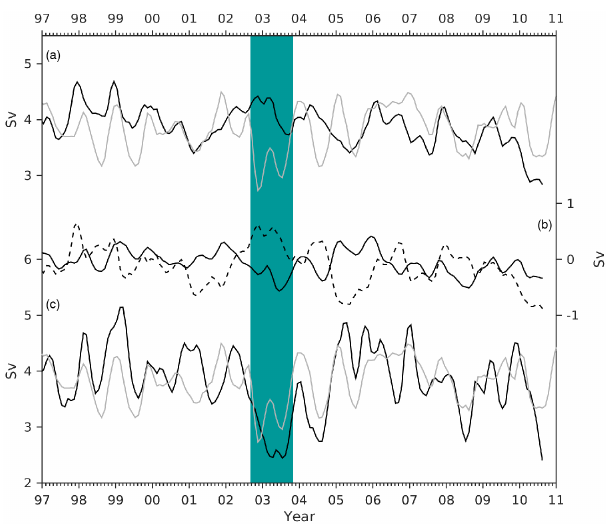
Figure 2. Three-month running mean time series of observed (grey; see Sect. 4.2) and modelled (black) IF-inflow (a) . Anomalies (run- ning mean) in modelled components on the Icelandic side (dashed) and Faroe side (solid) are shown in (b) . Modelled transport of wa- ter denser than 27.8kg × m − 3 across a model section north from the Faroes close to the observational N-section (Fig. 1a) is shown (black) together with observed IF-inflow (grey) in (c) . The shaded bar indicates the